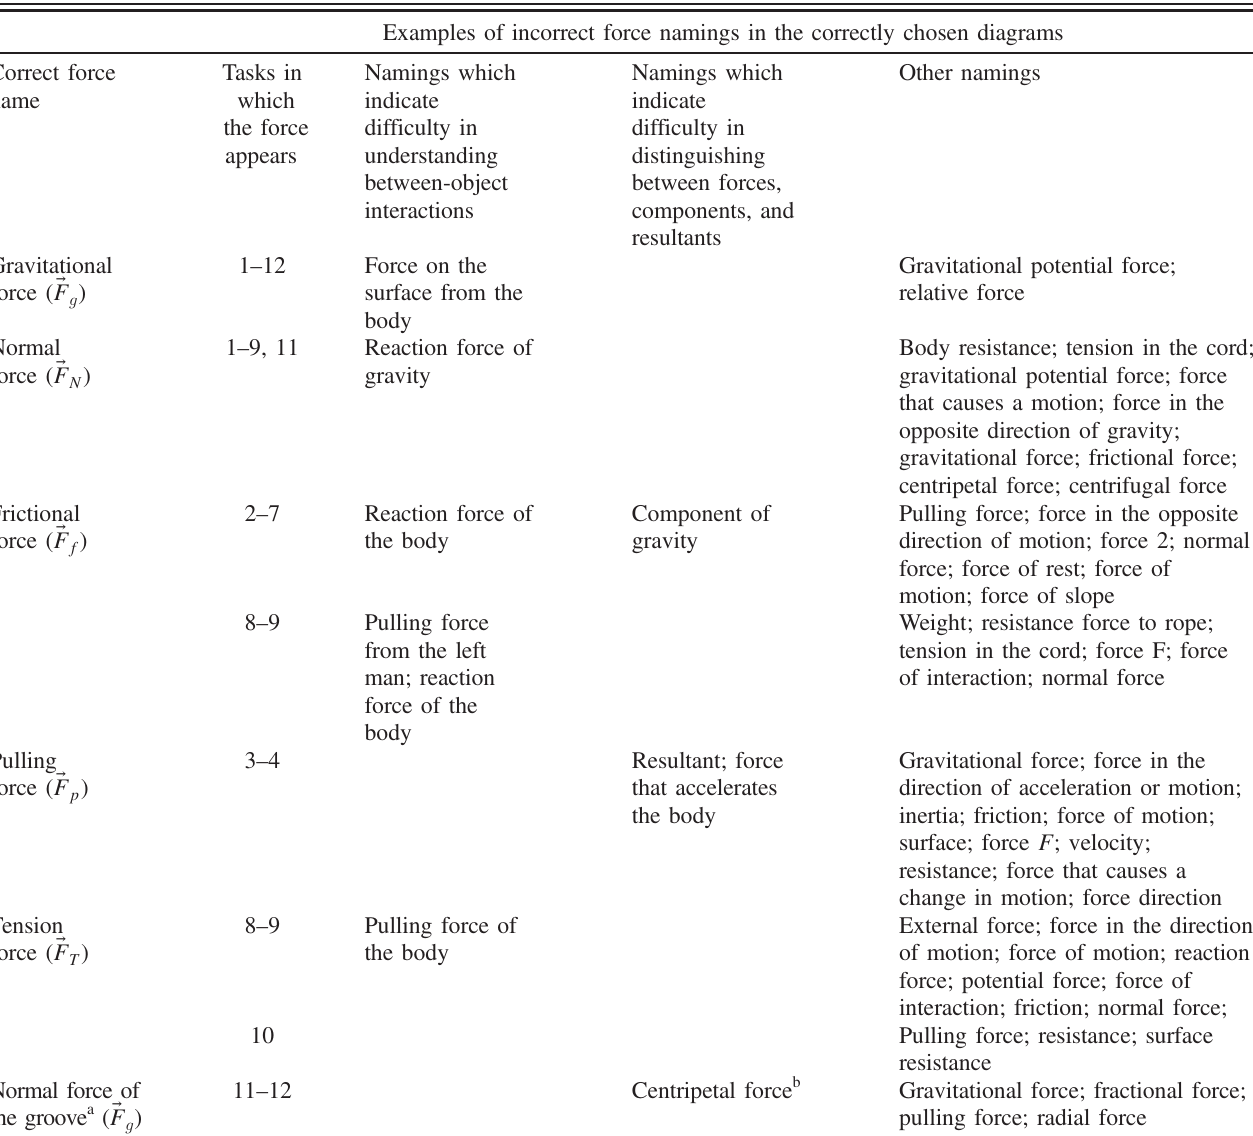
TABLE V. List of correct names of forces, tasks in which the corresponding forces appear in the correct diagrams, and examples of the corresponding incorrect namings of forces on pretest and